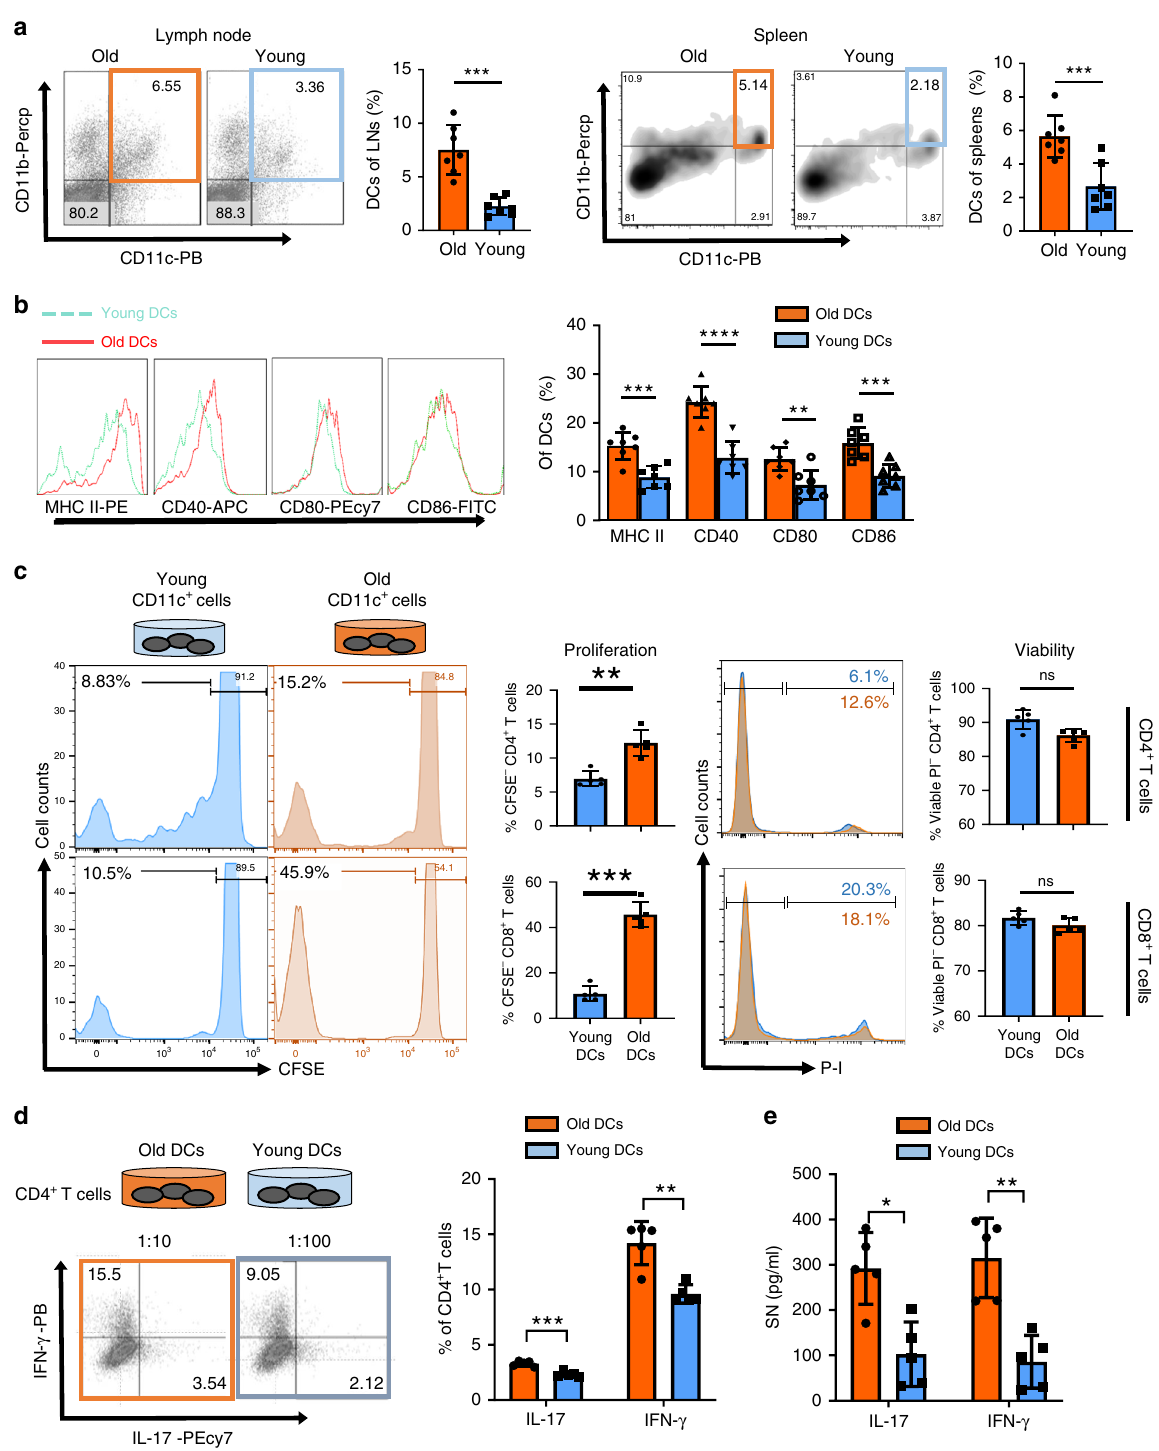
Fig. 1 Dendritic cells from old mice exhibit an activated phenotype and promote Th1 and Th17 T cell responses. Single cell suspensions of lymph nodes and spleens from old and young C57BL/6 mice were labeled with anti-CD11c, anti-CD11b, anti-MHC class II, anti-CD40, anti-CD80, and anti-CD86. a The frequency of CD11b + CD11c + DCs in lymph nodes ( p = 0.0006) and spleens ( p = 0.0023), and b the expression of costimulatory molecules (MHC-II: p = 0.0005/CD40: p < 0.0001/CD80: p = 0.0035/CD86: p = 0.0007) by splenic DCs were assessed by fl ow cytometry. c Proliferative capacities of CD4 + ( p = 0.0079) and CD8 + T cells ( p = 0.0079) co-cultured with DCs from old and young mice were determined using CFSE dilution and viability assessed using propidium iodide ( d ) CD4 + T cells from young mice were co-cultured with CD11b + CD11c + DCs isolated from young and old mice and ( e ) pro-in fl ammatory cytokine expression was assessed by fl ow cytometry (IL-17: p = 0.0002/IFN- γ : p = 0.0013) and ELISA (Il-17: p = 0.004/IFN- γ : p = 0.0079); ( n = 7 biologically independent animals), results are representative of at least three independent experiments. Column plots display mean with standard deviation. Statistical signi fi cance was determined by using two-tailed Mann – Whitney-test. Asterisks indicate p values * p ≤ 0.05, ** p ≤ 0.01, and *** p ≤ 0.001, only signi fi cant values are shown. Source data are provided as a Source Data fi